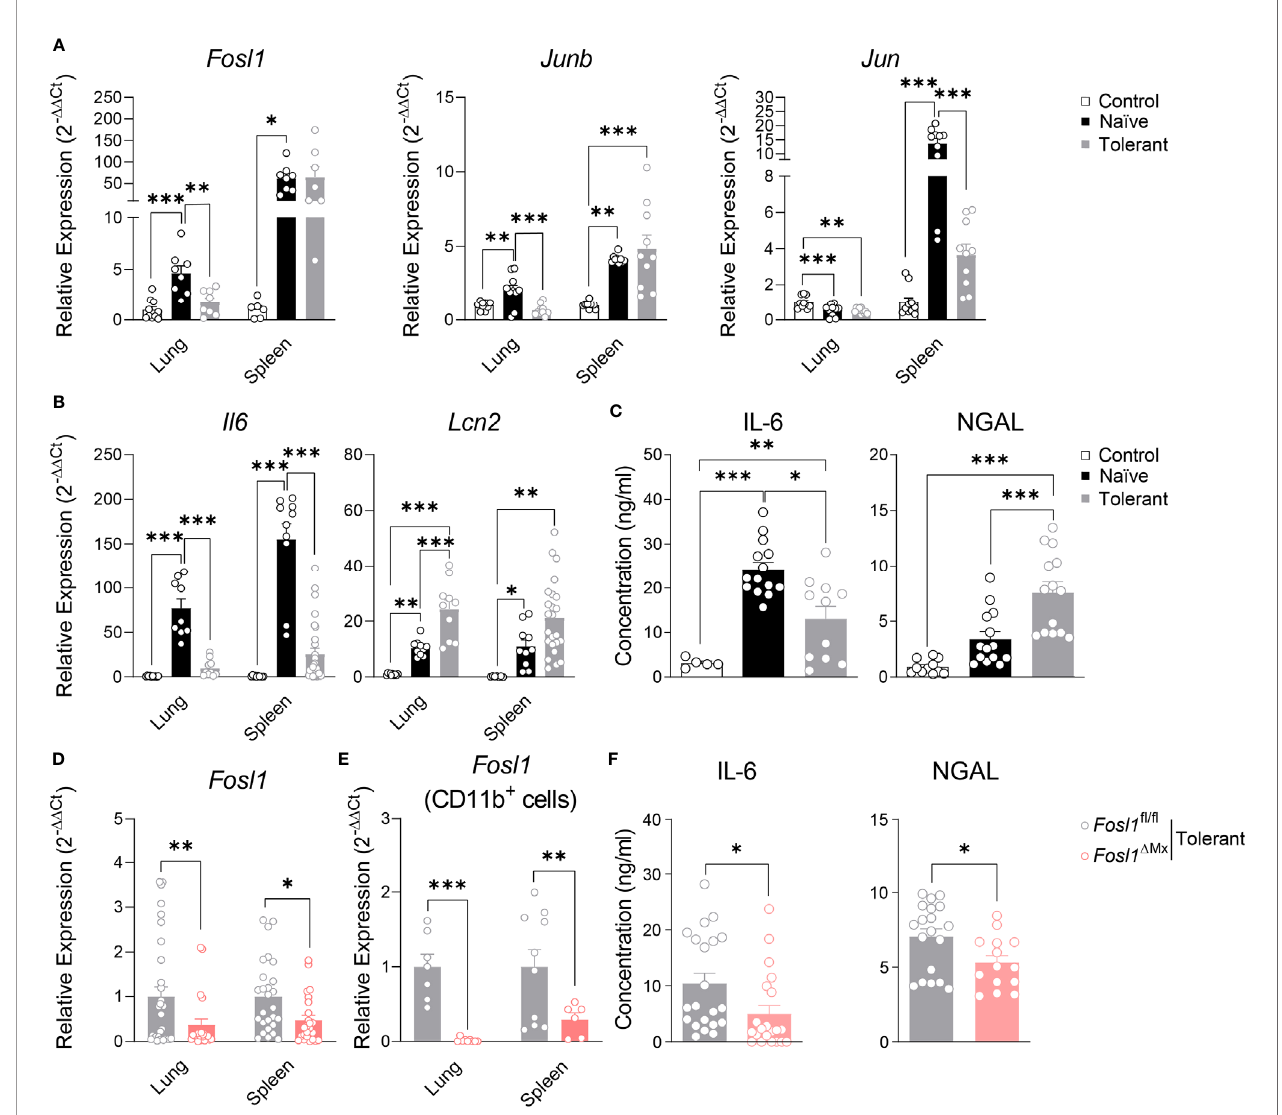
FIGURE 6 | Increased expression of Lcn2 in the immunosuppressive phase of sepsis is reduced in Fosl1 Δ Mx mice. (A, B) Quantitative RT-PCR analysis of AP-1 transcription factors (A) and Il6 and lcn2 genes (B) in lung and spleen of control, naïve or tolerant wild type mice 2 h after LPS infection. (C) IL-6 and NGAL levels in serum of control, naïve or tolerant wild type mice 2 h after LPS infection. (D, E) Quantitative RT-PCR analysis of Fosl1 transcription factor genes in total organ (D) or CD11b + cells (E) from lungs and spleens of Fosl1 Δ Mx and the littermate mice in tolerant state, normalized to the expression of Actb . (F) IL-6 and NGAL levels in serum of Fosl1 Δ Mx and the littermate mice in tolerant state. Graph points indicate individual mice. Data are shown as mean ± s.e.m. *p < 0.05; **p < 0.01; ***p < 0.001 by one-way ANOVA with Tukey ’ s multiple comparisons in (A – C) and student t test in (D – F)